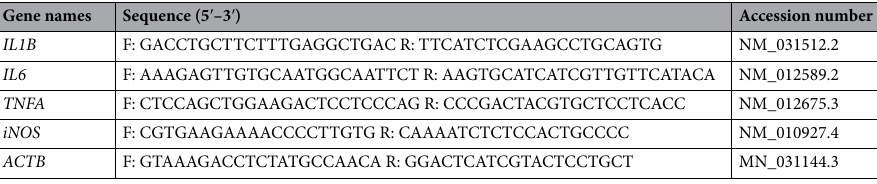
Table 1. List of primer sequences used for the mRNA level